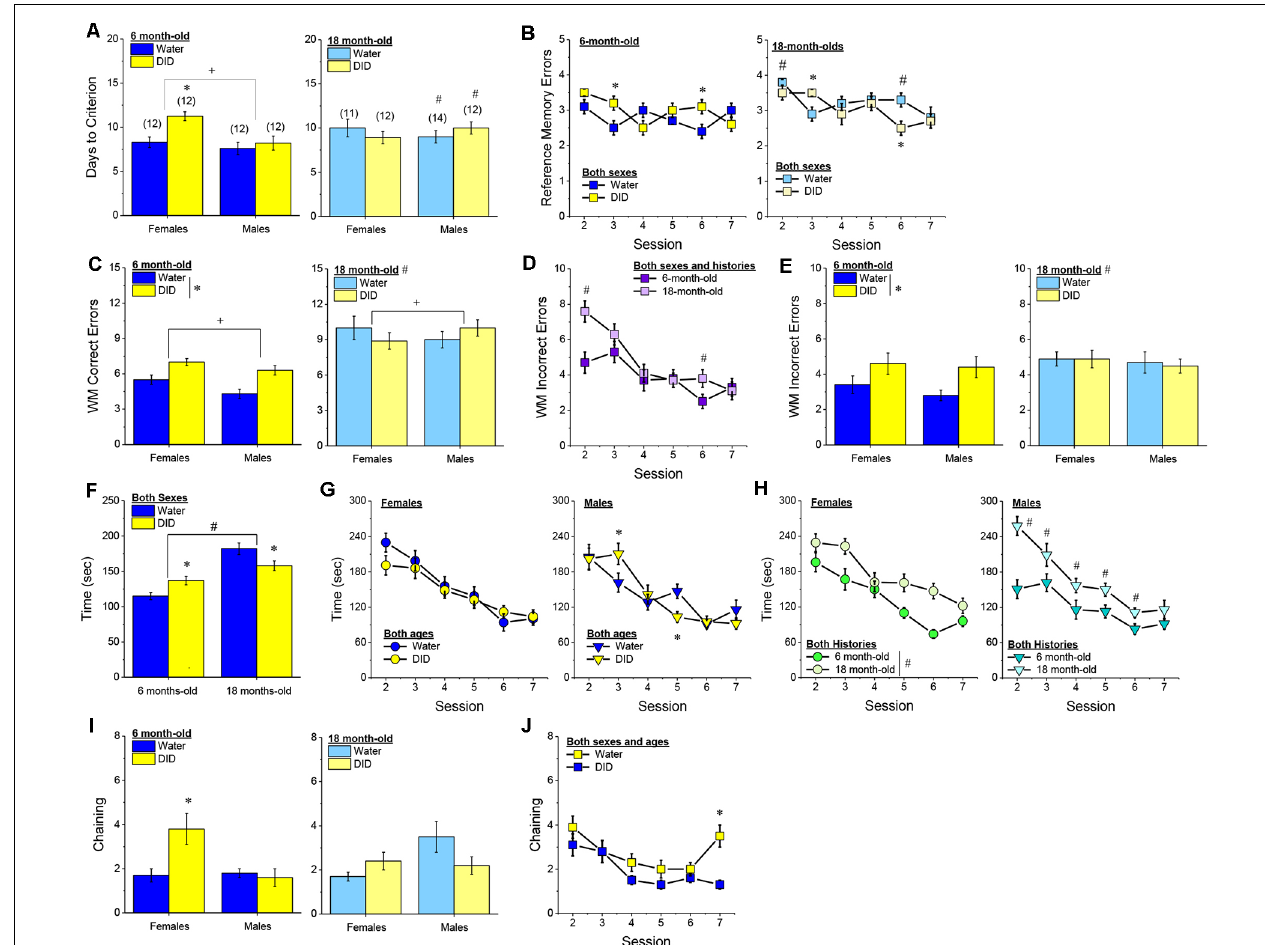
FIGURE 12 | Effects of binge drinking during later maturity (6 months of age) and old age (18 months of age) on radial arm maze performance in isogenic C57BL/6J mice. (A) The 6 month-old, binge drinking (DID), female C57BL/6J mice in Experiment 3 required more time than their water-drinking (Water) controls to reach asymptotic performance in the radial arm maze, with 18-month-old males also requiring more time than their 6-month-old counterparts, regardless of DID status. (B) A complex interaction between age and binge drinking history was observed for the change in reference memory errors during the first week of radial arm maze testing, that reflected a more consistent tendency for 6-month-old DID mice to commit more errors than their Water controls. (C) Although 18-month-old mice committed more working memory correct errors, on average, than the younger mice, only 6-month-old DID mice committed more of this error type than their water controls. (D) Likewise, 18-month-old mice committed more working memory incorrect errors than 6-month-old mice during radial arm maze training, however (E) only 6-month-old DID mice committed more working memory incorrect errors than their Water controls. (F) No significant effect of binge drinking was detected for the number of reference memory errors (B) , or working memory (WM) correct errors (C) committed over the first week of radial arm maze training. Female DID mice committed more WM incorrect errors than their Water controls (D) , but we detected no group differences in the time taken to navigate the maze (E) . (F) Although 18-month-old mice required more time, on average than 6-month-old mice to navigate the maze, 6 and 18-month-old DID mice required more and less time, respectively, to complete the maze than their Water controls. (G) Binge drinking altered the time-course of radial arm maze learning selectively in male mice and (H)